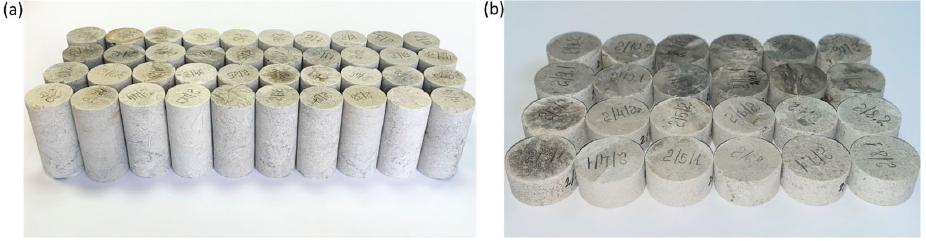
Figure 2. Photographs depicting prepared limestone samples: ( a ) samples 50.8 mm in height and 25.4 mm in diameter; ( b ) samples 12.7 mm in thickness and 25.4 mm in diameter.